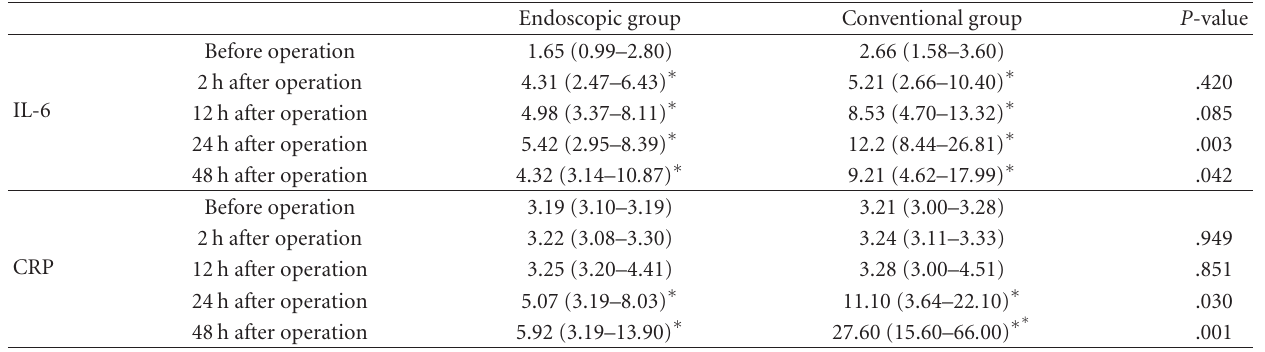
Table 3: Variation of serum IL-6 (pg/ml) and CRP (mg/L) levels after